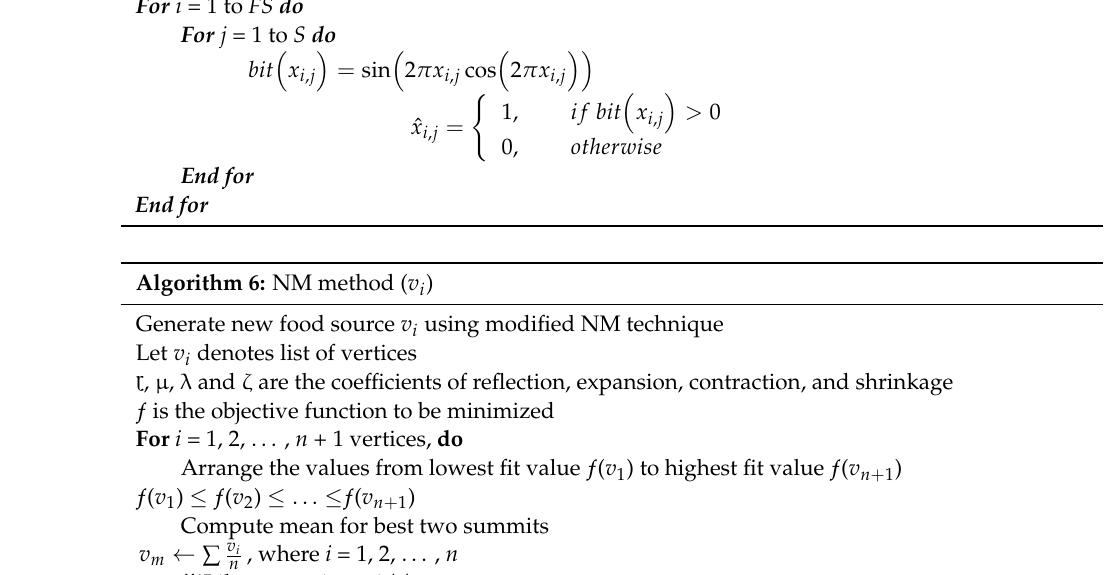
Algorithm 5: BinaryConv( x i , j )